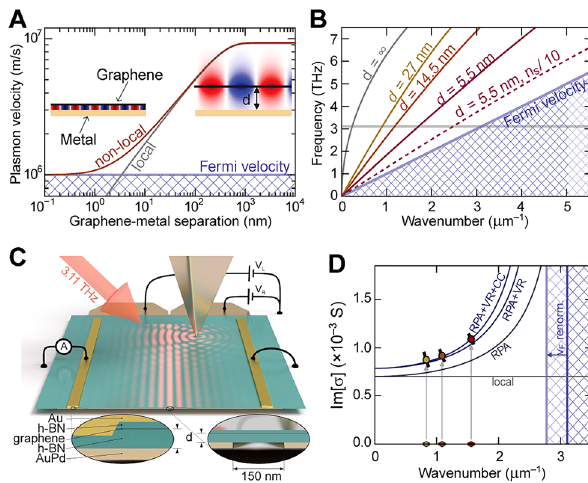
Figure 9: Probing nonlocal effects in graphene with IGPs. (A)Grapheneplasmonvelocityasafunctionoftheseparation d inthe graphene – metal system. (B) Frequency – wavenumber dispersion of the plasmon at various d . (C) A metallized tip scans over a graphene sheet that has been encapsulated in hBN and placed on a split metallic fi lm. (D) Experimentally extracted graphene conductivity σ ( q , ω ), compared with theoretical approximations for the interacting electron system in graphene: RPA, with added velocity renormalization (RPA + VR), and then with compressibility correction (RPA + VR + CC), with the local RPA appearing as a horizontal line. Adapted with permission from [33]. Copyright 2017,